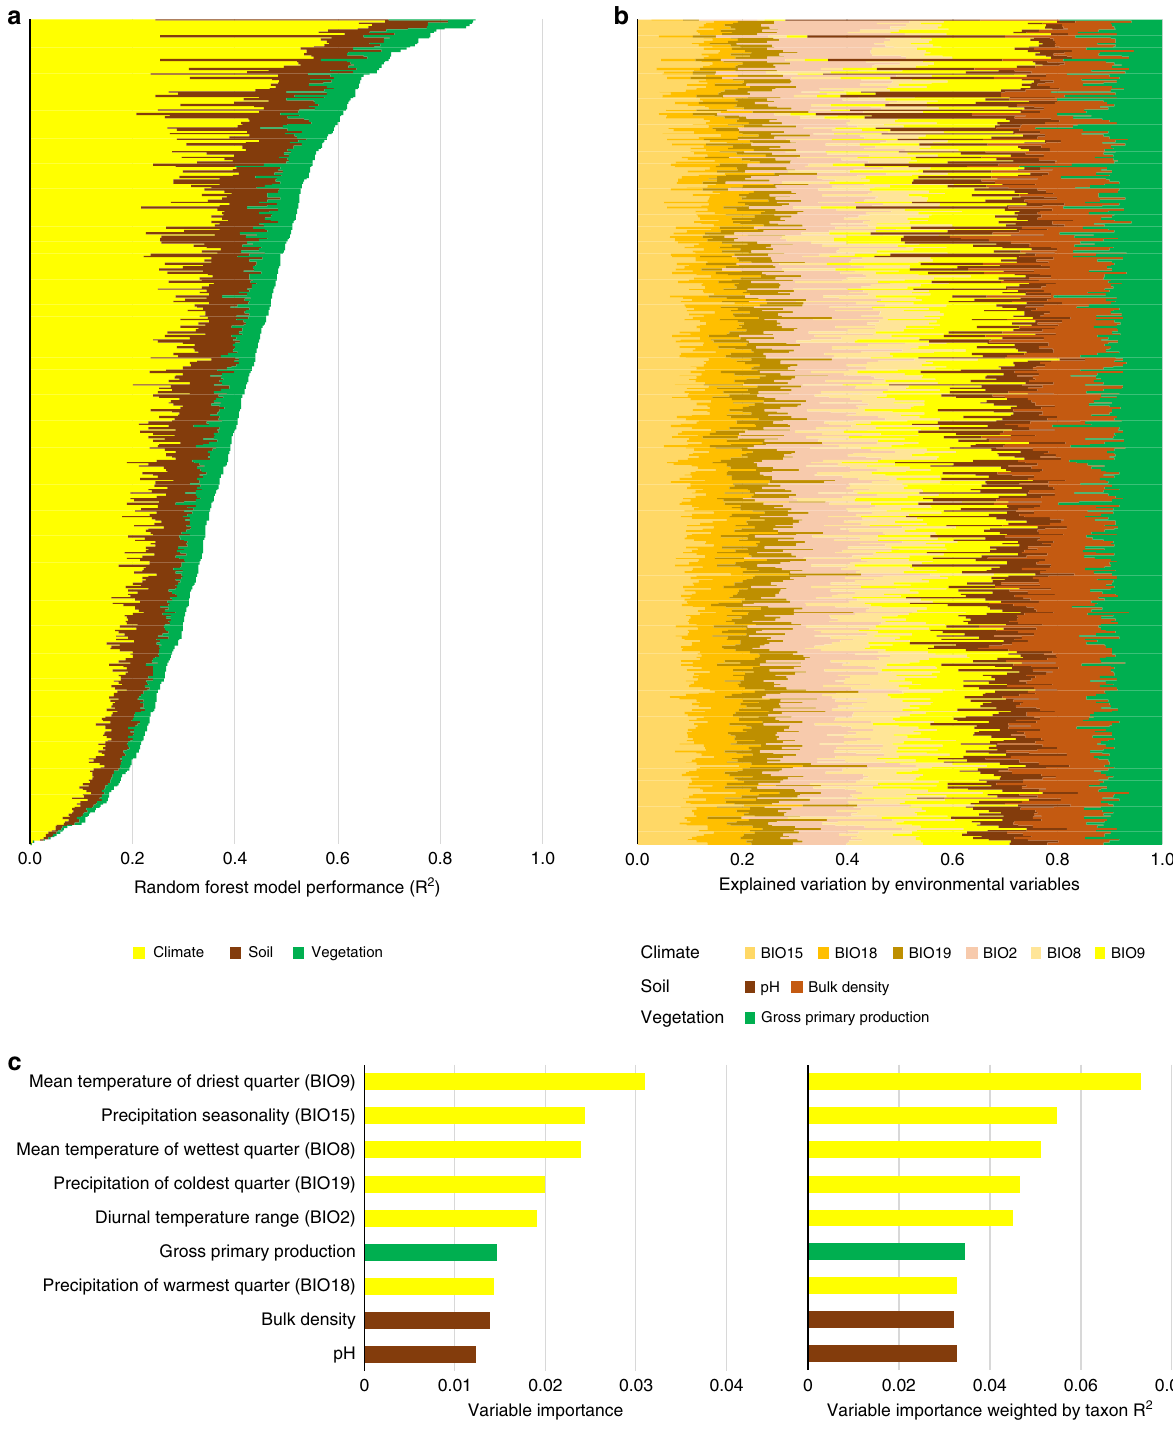
Fig. 2 Environmental variables explaining the global distribution of the most frequent fungal taxa. a Random forest model performance for 457 fungal taxa where out-of-bag R 2 > 0. b Contribution of climatic, soil and vegetation variable categories to the variation explained by the complete random forest model for each fungal taxon. c Importance of individual environmental variables across models for all fungal taxa showing raw variable importance and variable importance weighted by out-of-bag R 2 for each